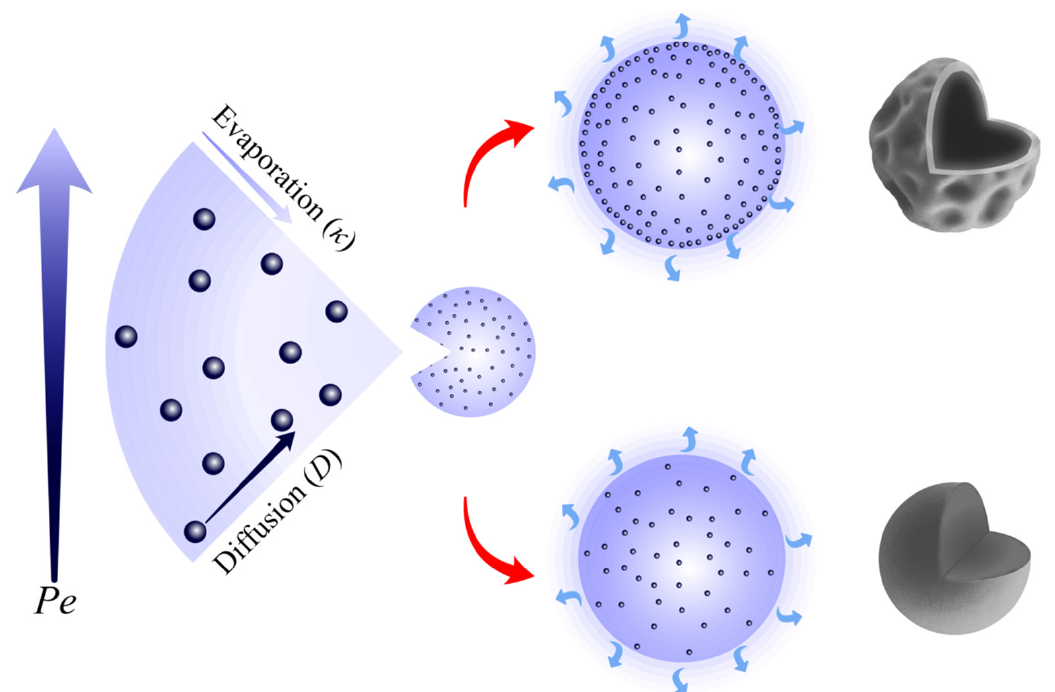
Figure 5. An illustration of the Péclet number concept. The higher the Péclet number, the higher the rate of radial shrinkage of spray droplets relative to the rate of inward diffusion of solute molecules.